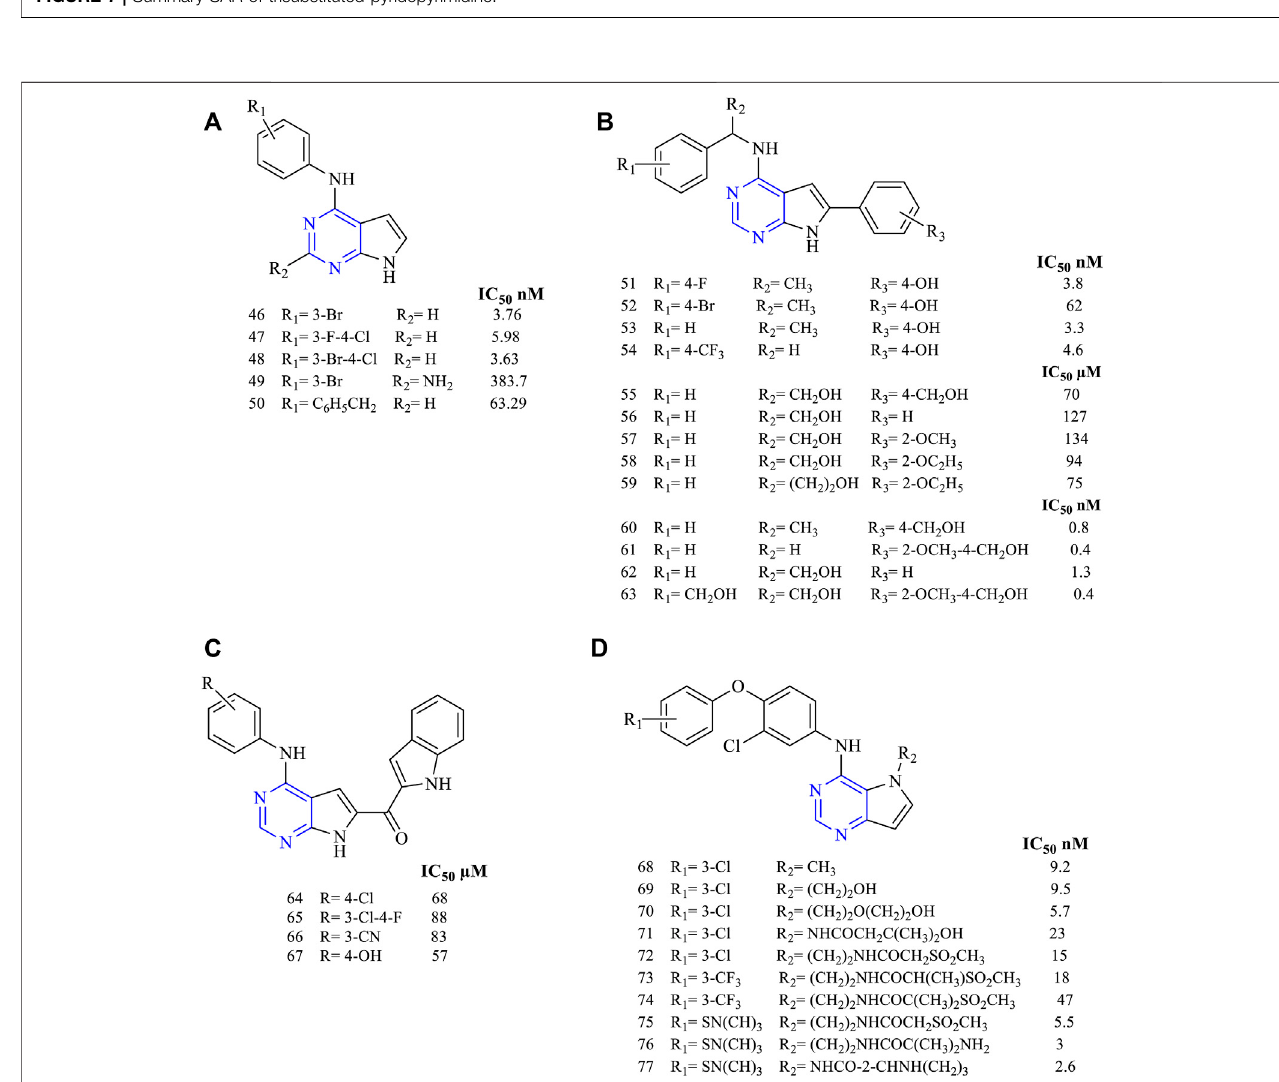
FIGURE 8 | Chemical structure of (A) 2,4-disubstituted pyrrolo[2,3- d ]pyrimidine, (B) 4,6-disubstituted pyrrolo[2,3- d ]pyrimidine, (C) 4,6-disubstituted-7H-pyrrolo [2,3- d ]pyrimidine, and (D) 4,5-disubstituted pyrrolo[3,2- d ]pyrimidine.